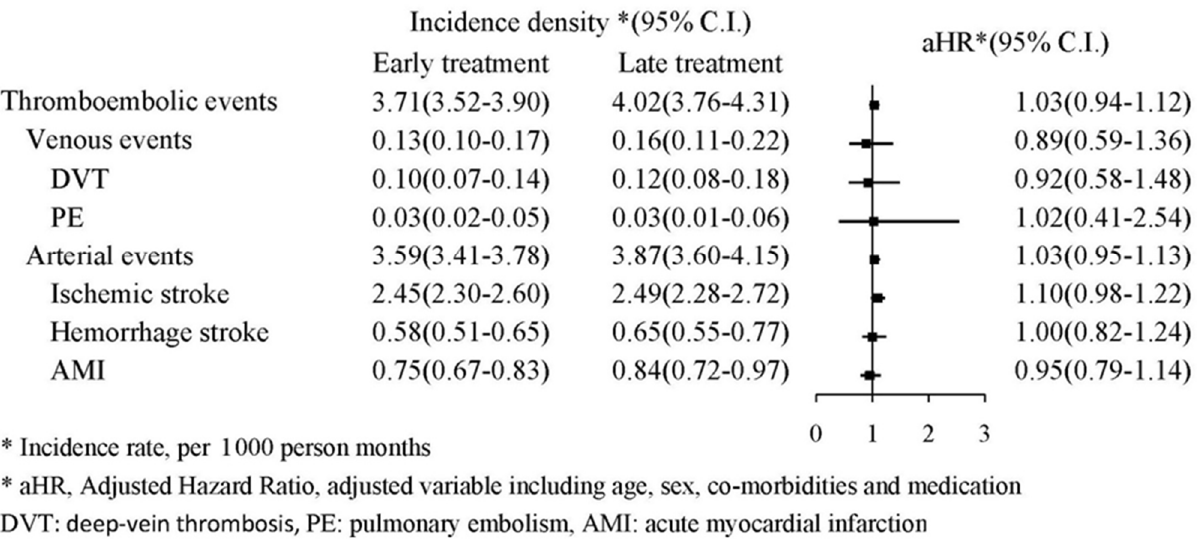
Figure 5. Flowchart of patient selection.